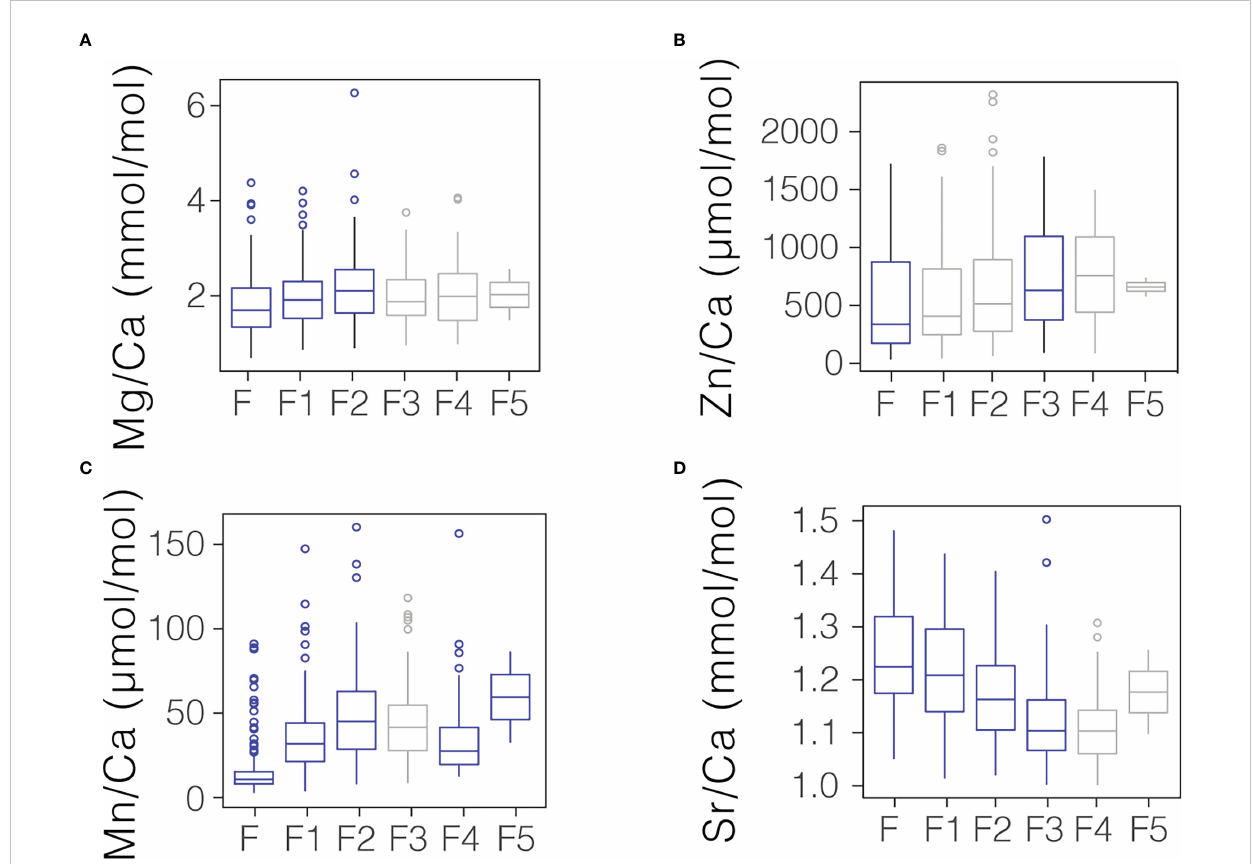
FIGURE 4 Comparison of (A) Mg/Ca, (B) Zn/Ca, (C) Mn/Ca, and (D) Sr/Ca found in the youngest 6 chambers of G. hexagonus . In each plot, F refers to the youngest or “ fi nal ” chamber, with older chambers progressing sequentially from this point. Chambers values which were signi fi cantly different ( p < 0.05) from the subsequent chamber are shown in blue; those that were not signi fi cantly different are shown in grey. The boxes denote the 1 st and 3 rd quartiles and the center bar the